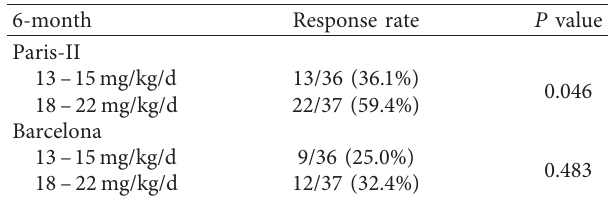
Table 2: Response by definition of Barcelona and Paris-II criteria at 6 months.